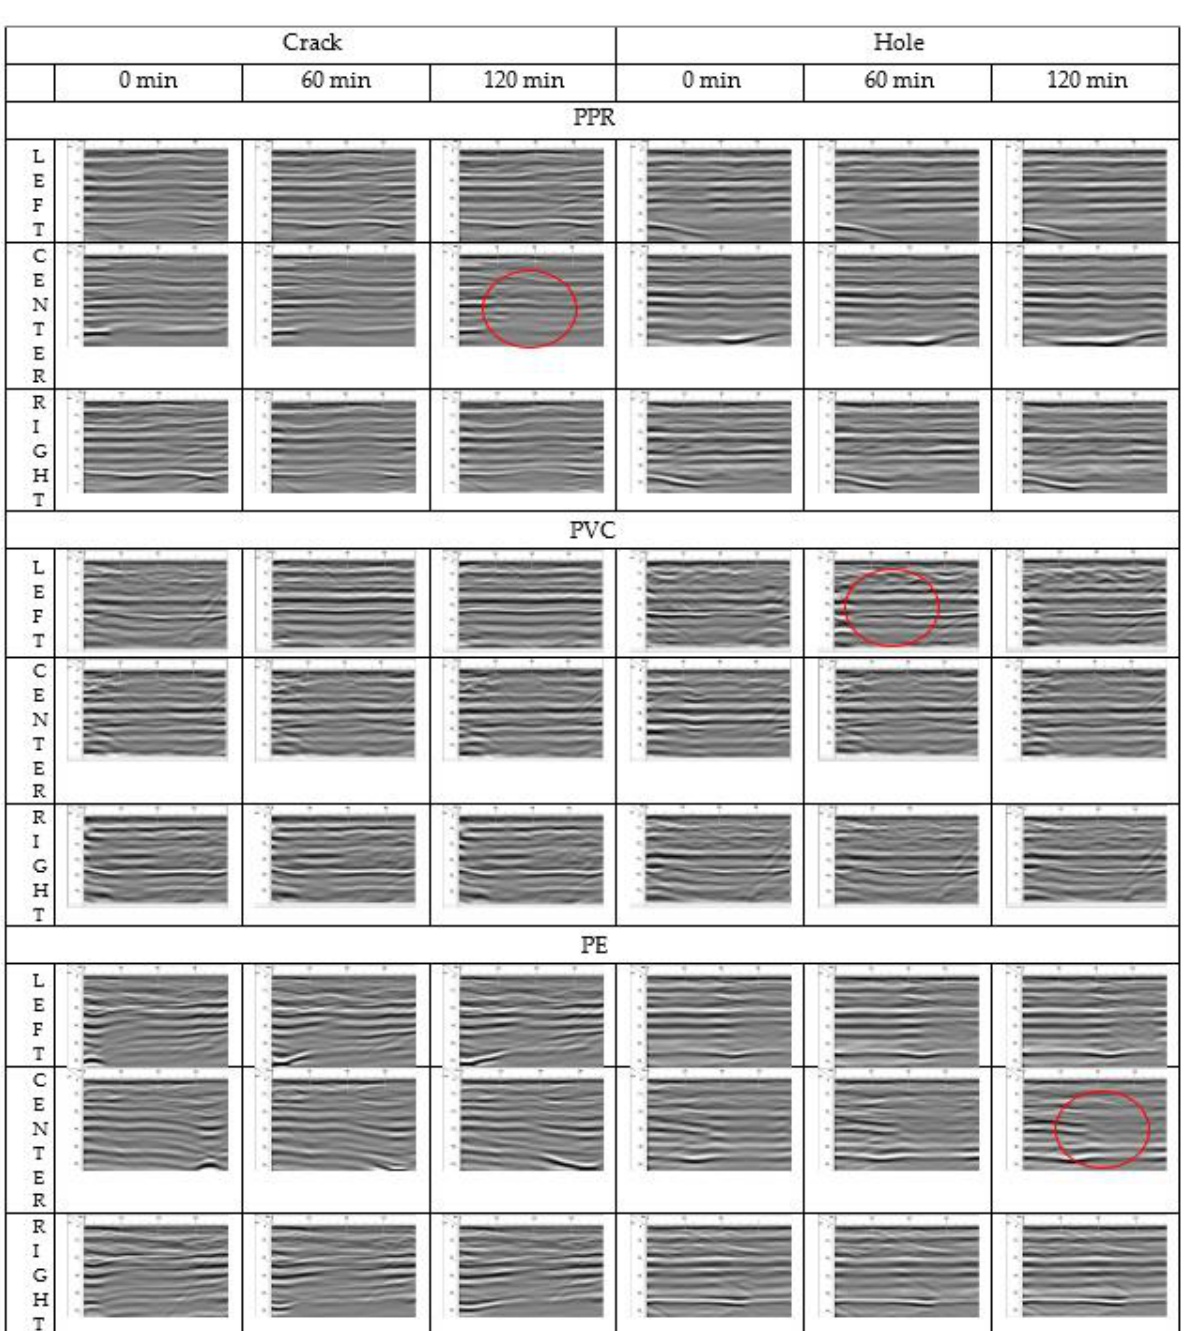
Figure 11. GPR images obtained on PPR, PVC and PE setup with 10% soil moisture content.